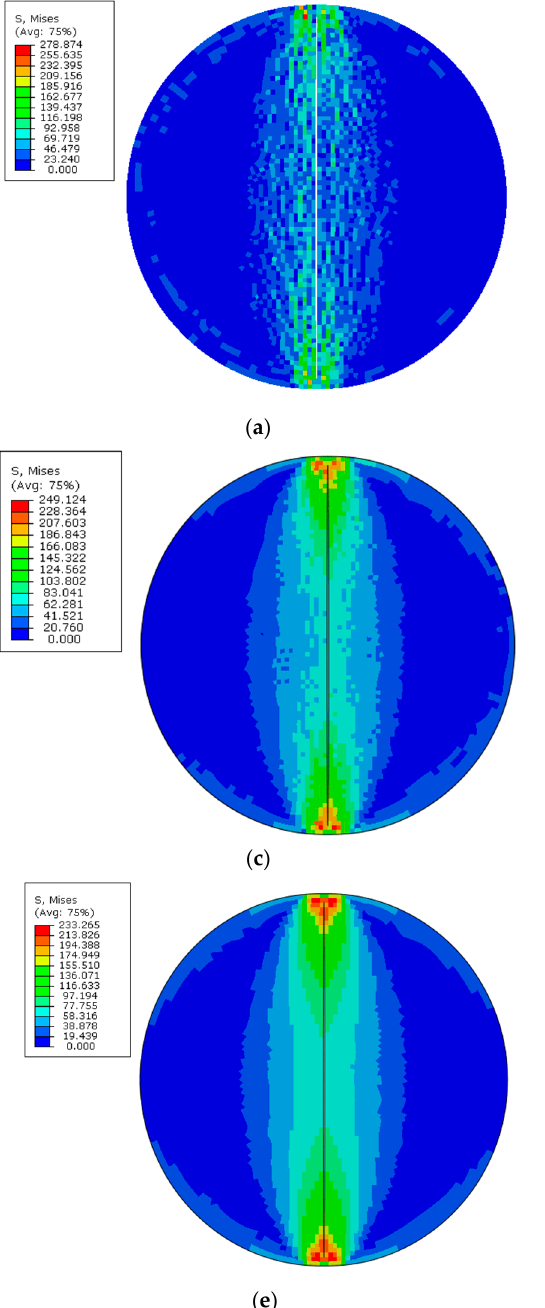
Figure 13. Numerical simulation of Brazilian splitting for heterogeneous model. ( a ) m = 1.5; ( b ) m = 5; ( c ) m = 10; ( d ) m = 100; ( e ) m = 1000.